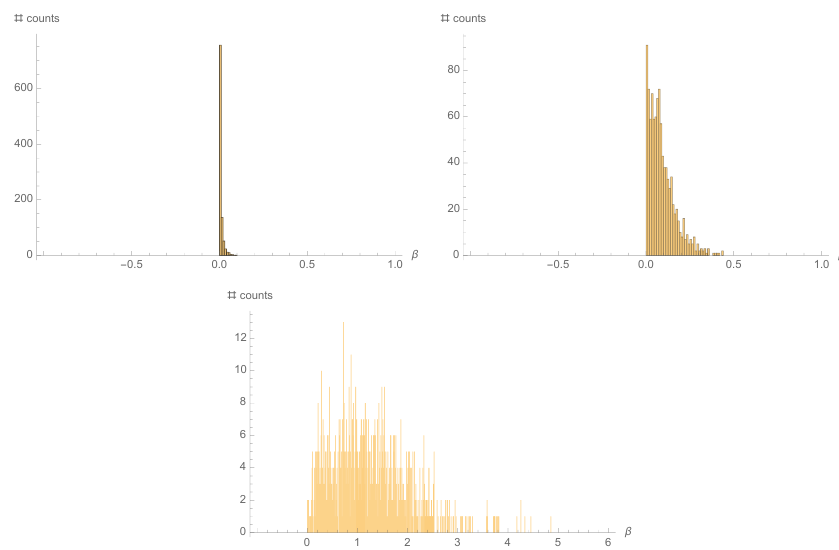
Figure 7 . Histogram of the values of the impact parameter for the bundle of worldlines resulting from the random extraction of 1000 points from a Gaussian distribution of the form (4.33), centred in ( p 1 , p 2 , q 1 , q 2 ) with variance σ = 0 . 01 . From left to right, the distributions are centred in: ( p 1 , p 2 , q 1 , q 2 ) = (1 , 1 , 0 , 0) , ( p 1 , p 2 , q 1 , q 2 ) = (1 , 1 , 1 , 1) , ( p 1 , p 2 , q 1 , q 2 ) = (1 , 1 , 4 , 4) , corresponding to values of the impact parameter β = 0 , β = 0 . 07 , β = 1 . 12 , respectively. Note the different range of the horizontal axis of the bottom plot compared to the other two. These histograms provide a first qualitative indication that the uncertainty δβ grows with the expectation value h β i